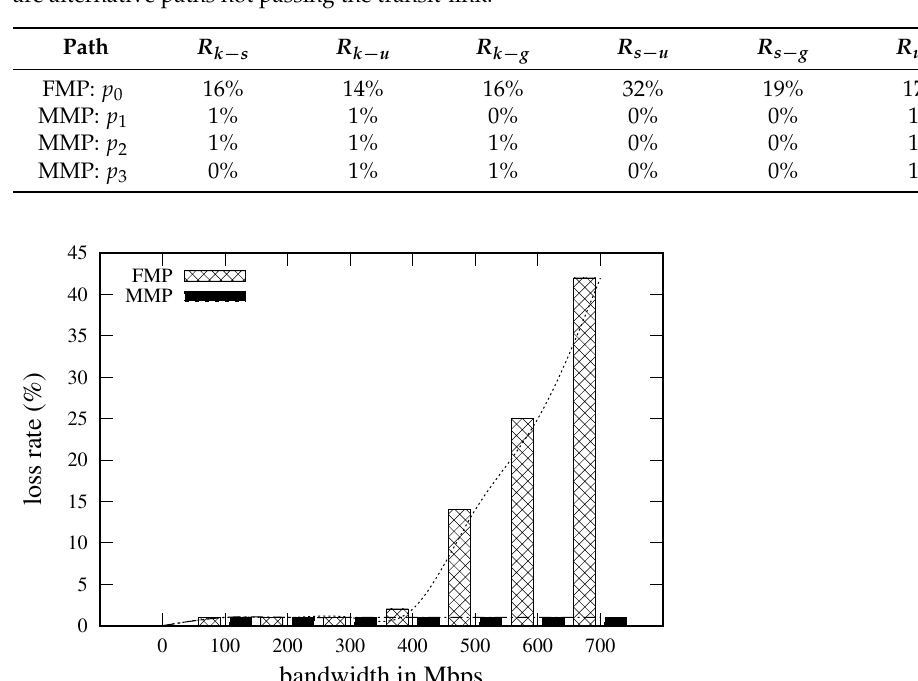
Table 3. Average loss rate during transit-link DDoS attack. FMP p 0 for each route R src − dst is an FMP path communicating through the transit-link between source and destination. MMP p 1 , p 2 , and p 3 are alternative paths not passing the transit-link.